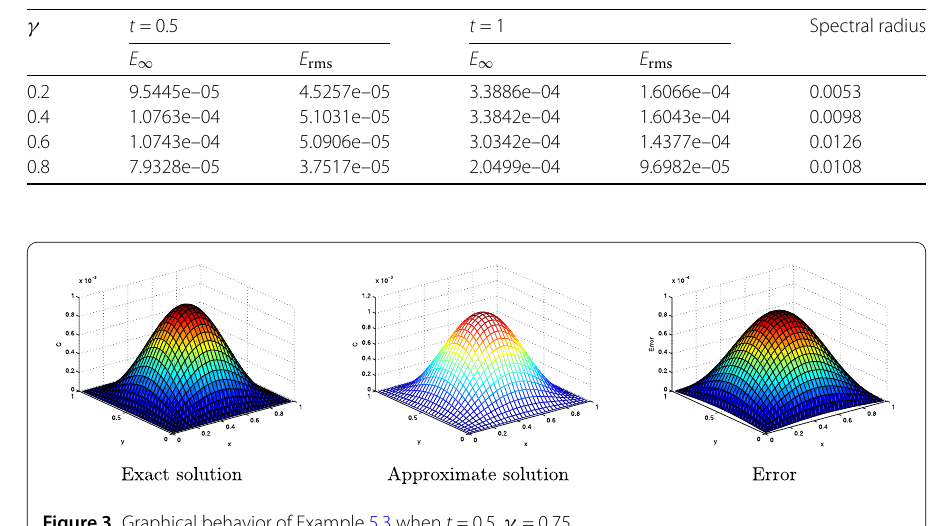
Figure 3 Graphical behavior of Example 5.3 when t = 0.5, γ = 0.75